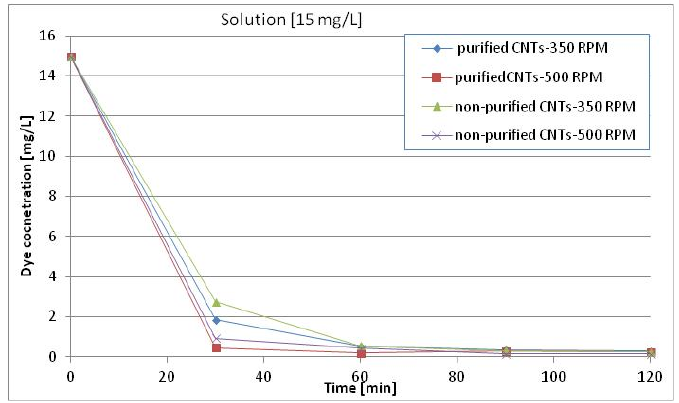
Figure 5. Changes in concentrations of Reactive Black-5 starting from 15 mg/L as a function of type of MWCNTs, purified and nonpurified, and stirring speed (revolutions per minute-RPM).